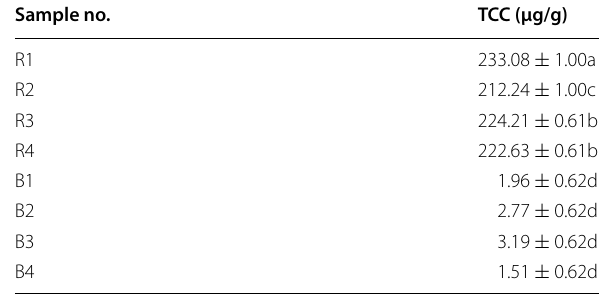
Data were expressed as mean same column marked with different small case letters were significantly ( p <